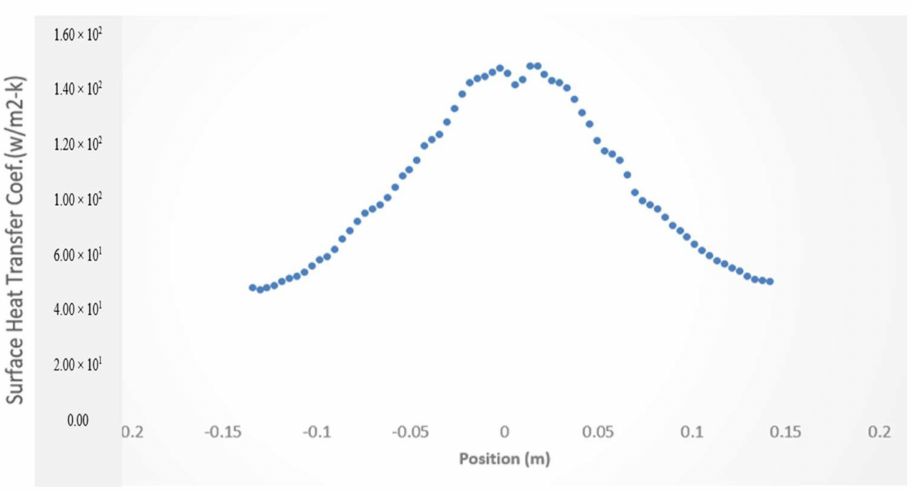
Figure 18. Heat transfer coefficient in the axial direction at Model